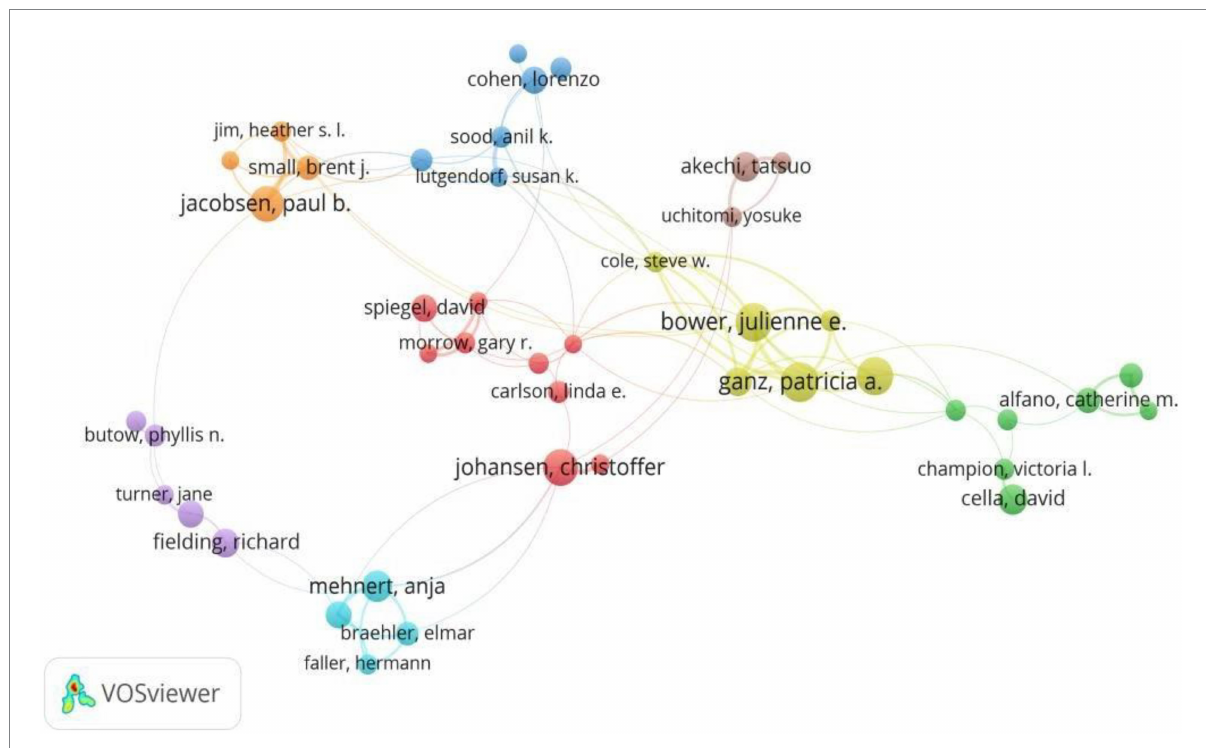
FIGURE 2 A visualization network of collaboration between authors on depression in breast cancer.